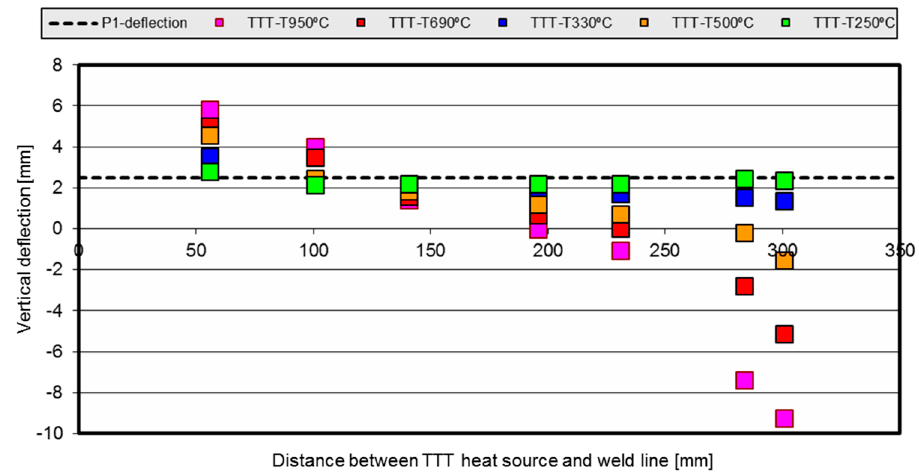
Figure 5. Vertical deflection comparison against torch temperature and torch position parametrization.